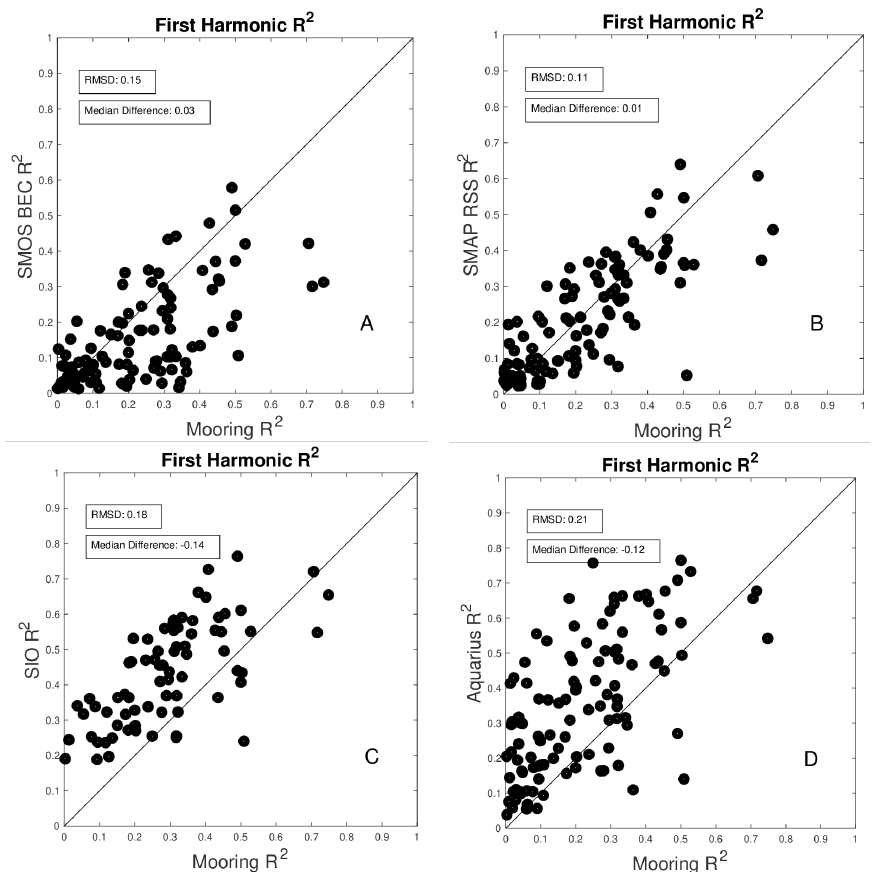
Figure 10. Scatterplots of fraction of variance, R 2 , in the annual harmonic captured by four products, compared to that captured by the moorings. R 2 values are based on the entirety of each dataset, including possibly nonoverlapping periods. Products are (a) SMOS BEC, (b) SMAP RSS, (c) SIO and (d) Aquarius.